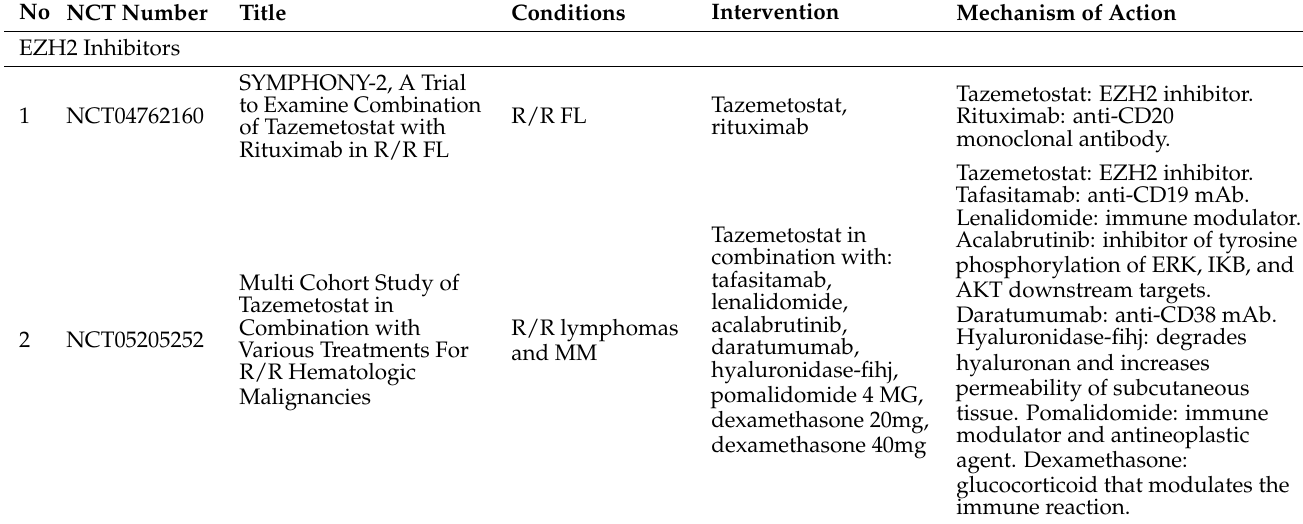
Table 2. Ongoing and completed clinical trials on histone methyltransferase inhibitors in hematologic ma-